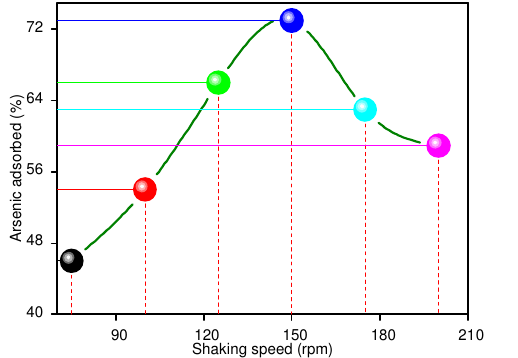
Fig. 7: Effect of Shaking Speed (rpm) on the Arsenic Adsorbed % by Shikarap Iron Ore, (Sorbent Dose 0.5g Per 50ml, As(III) Concentration 50 ppb, pH 6, Shaking Time 2h).